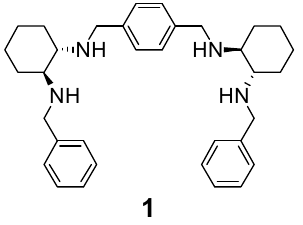
Figure 1. Structure of ligand 1 .